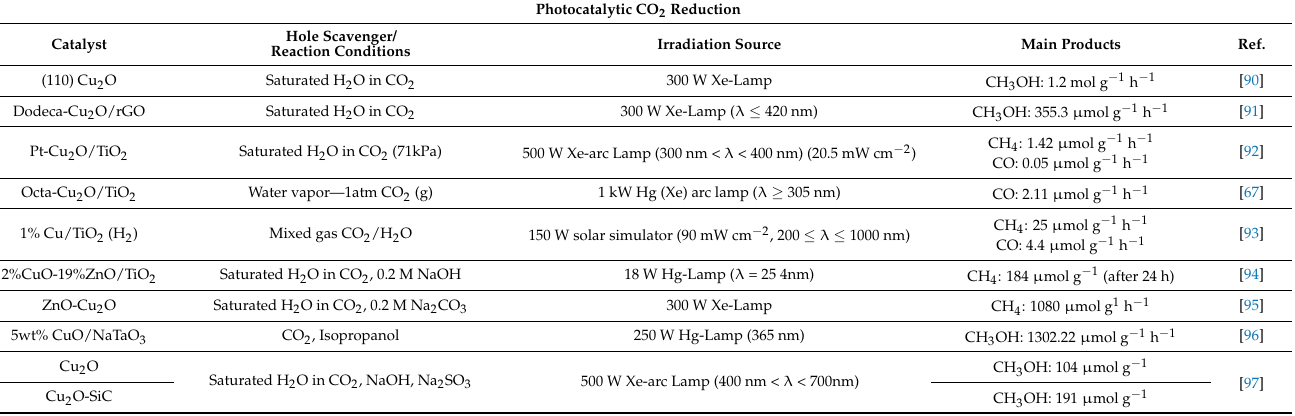
Table 5. Pertinent Cu-based semiconductors used for the photocatalytic CO 2 conversion into various chemical